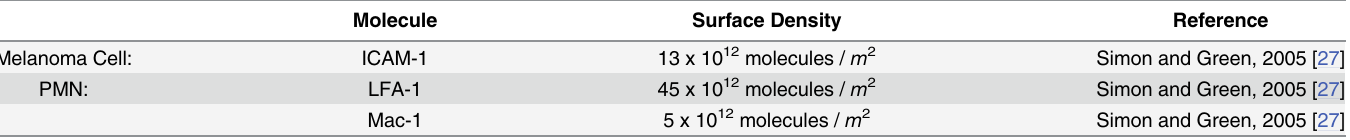
Table 3. Adhesion Molecule Surface